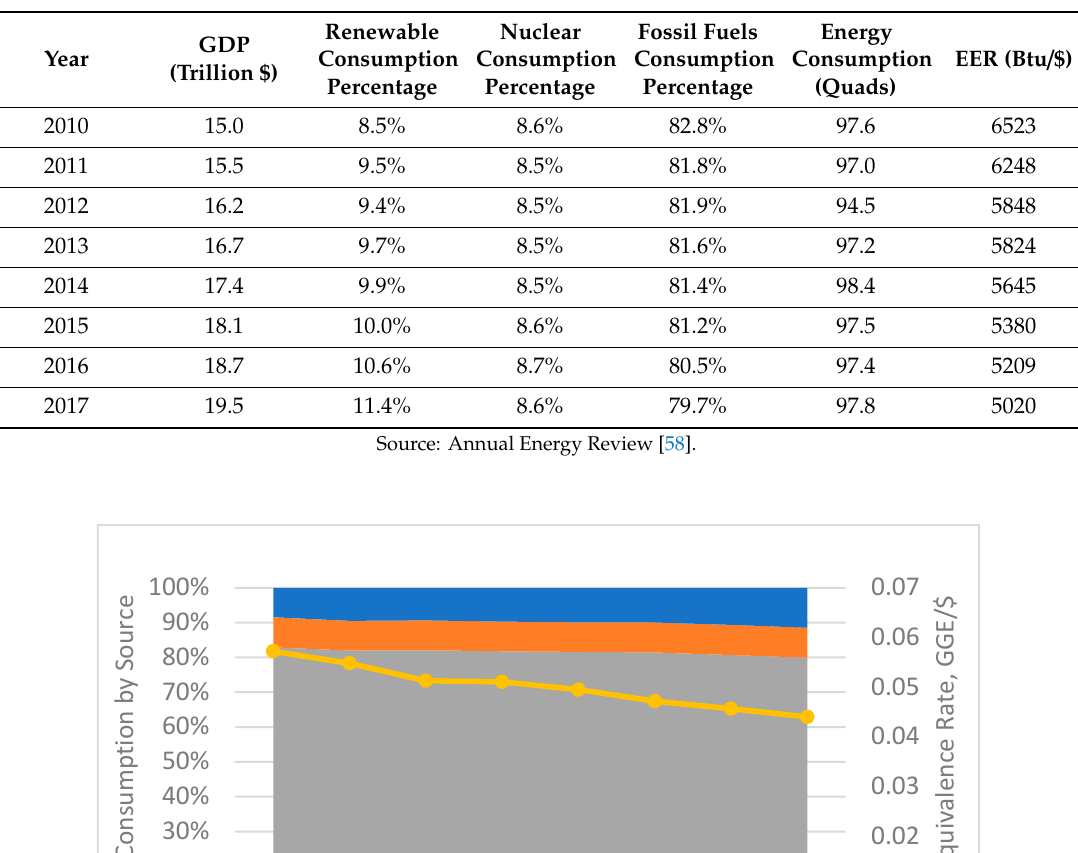
Table 5. National GDP (USD) and energy consumption statistics.